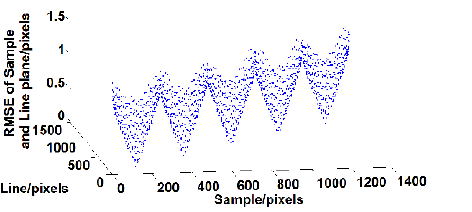
Figure 2. Residues distribution of Least Squares